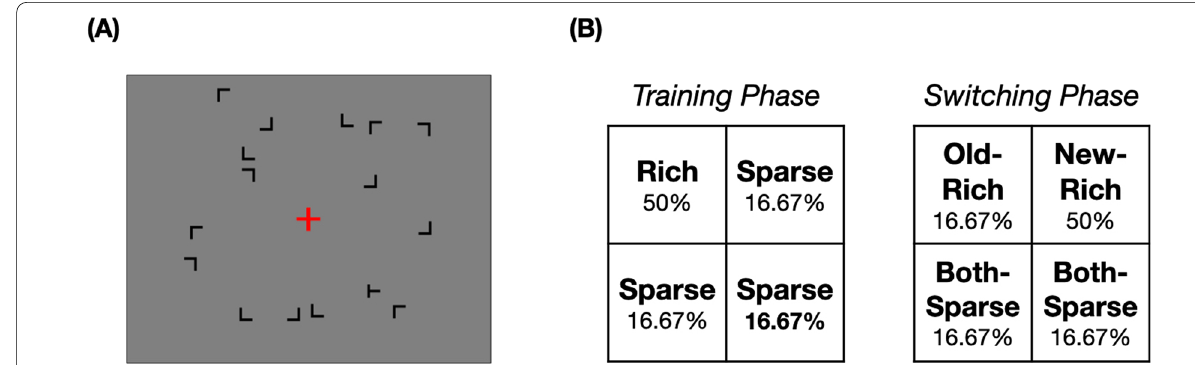
Fig. 1 Schematic description of the experiment. A A sample search display. The items are not drawn to actual scale. B Schematic description of target probability and condition names of the training phase (left) and the switching phase (right). The rich quadrants were counterbalanced by